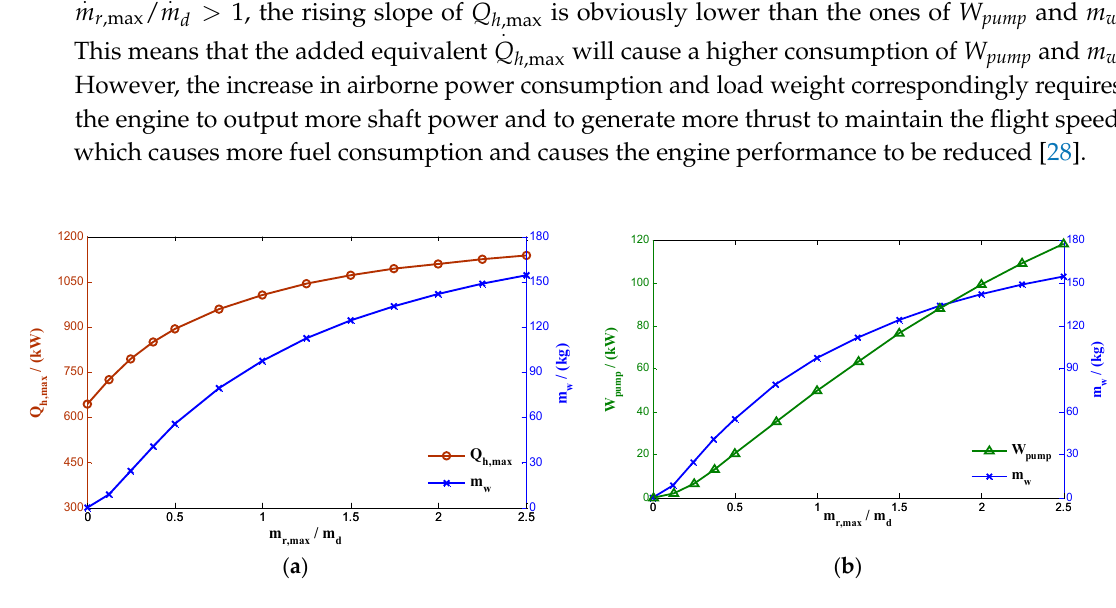
Figure 6. Influence of ,max and W pump . m m ,max r d